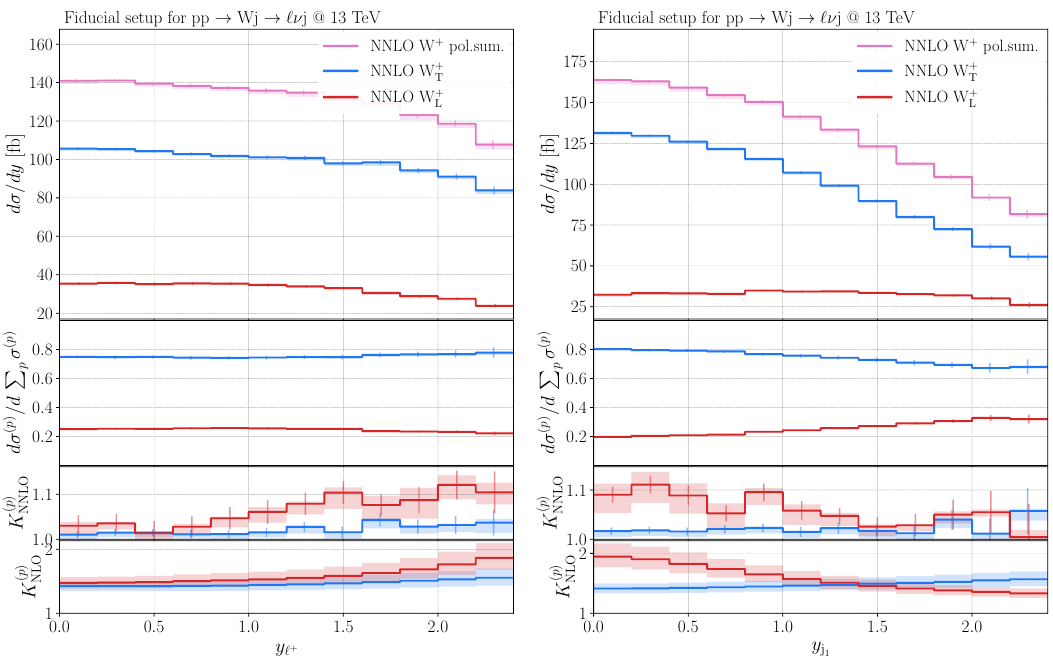
(left) and y (right), both in the fiducial j 1 ‘ +